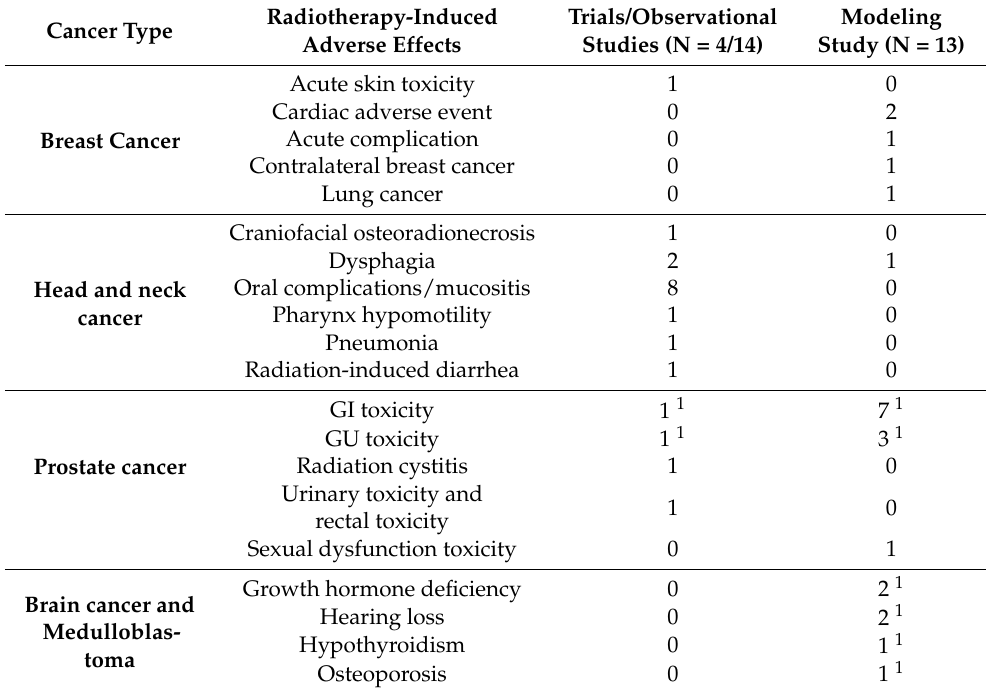
Table 2. Radiotherapy-induced adverse effects studied in included literature. Cancer